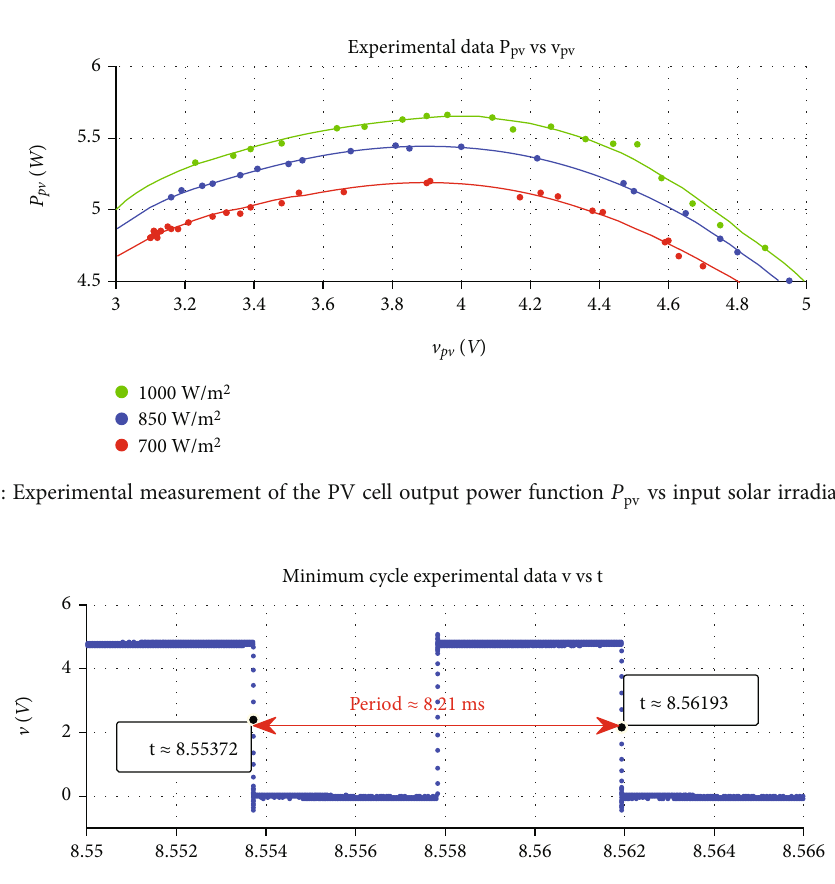
Figure 9: Minimum period of sampling cycle of the IDA-PBC strategy, due to the computing capacities of the hardware platform.